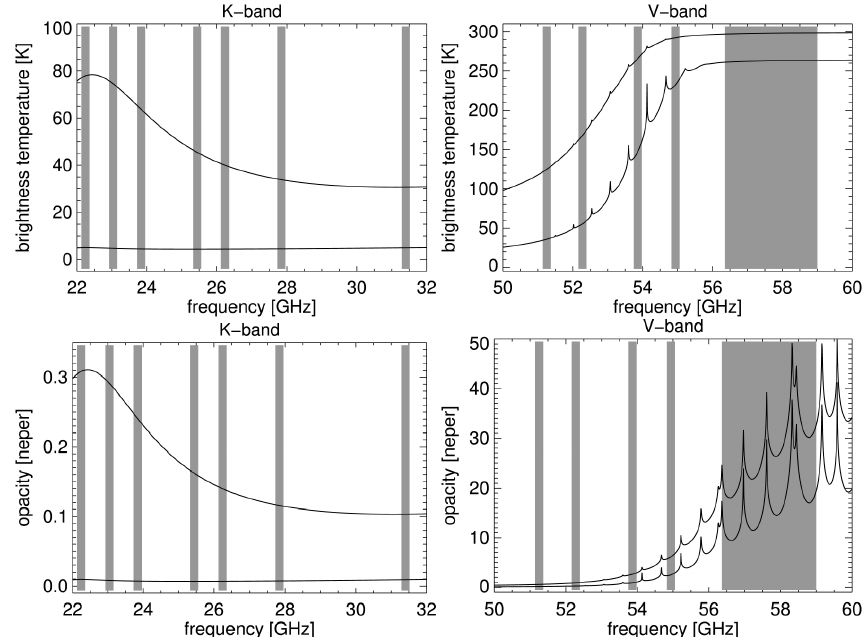
Fig. 1. Highly spectrally resolved brightness temperature ( T b , top panels) and opacity ( τ , bottom panels), calculated by the Rosenkranz’98 absorption model (Rosenkranz, 1998), for the spectral range covered by HATPRO-G2. Spectral features are the water vapor absorption line at 22.24GHz (left panels) and the oxygen absorption complex at 60GHz (right panels). At 530hPa, pressure broadening is reduced and single transitions can be recognized in the spectral wing of the oxygen absorption complex (lower lines). The upward-looking spectrum is plotted for a very dry (PWV=0.3mm) RHUBC-II radiosonde profile from 13 September 2009. For comparison the spectrum is calculated for sea-level conditions using a subtropical standard atmosphere (higher T b and τ values). HATPRO-G2 channels are illustrated by the width of band-pass filters (gray). Note that band-pass filters of the three most opaque channels